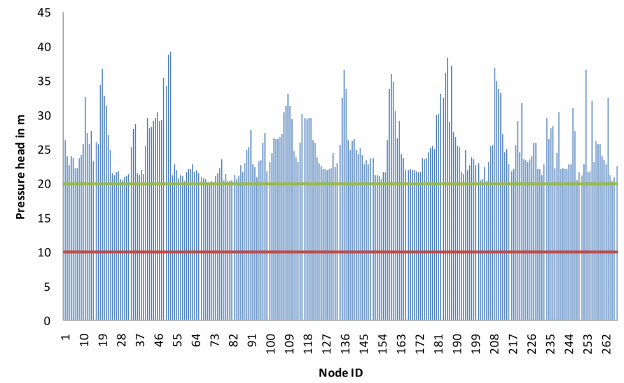
Figure 7. Nodal pressure head under no component failure condi-